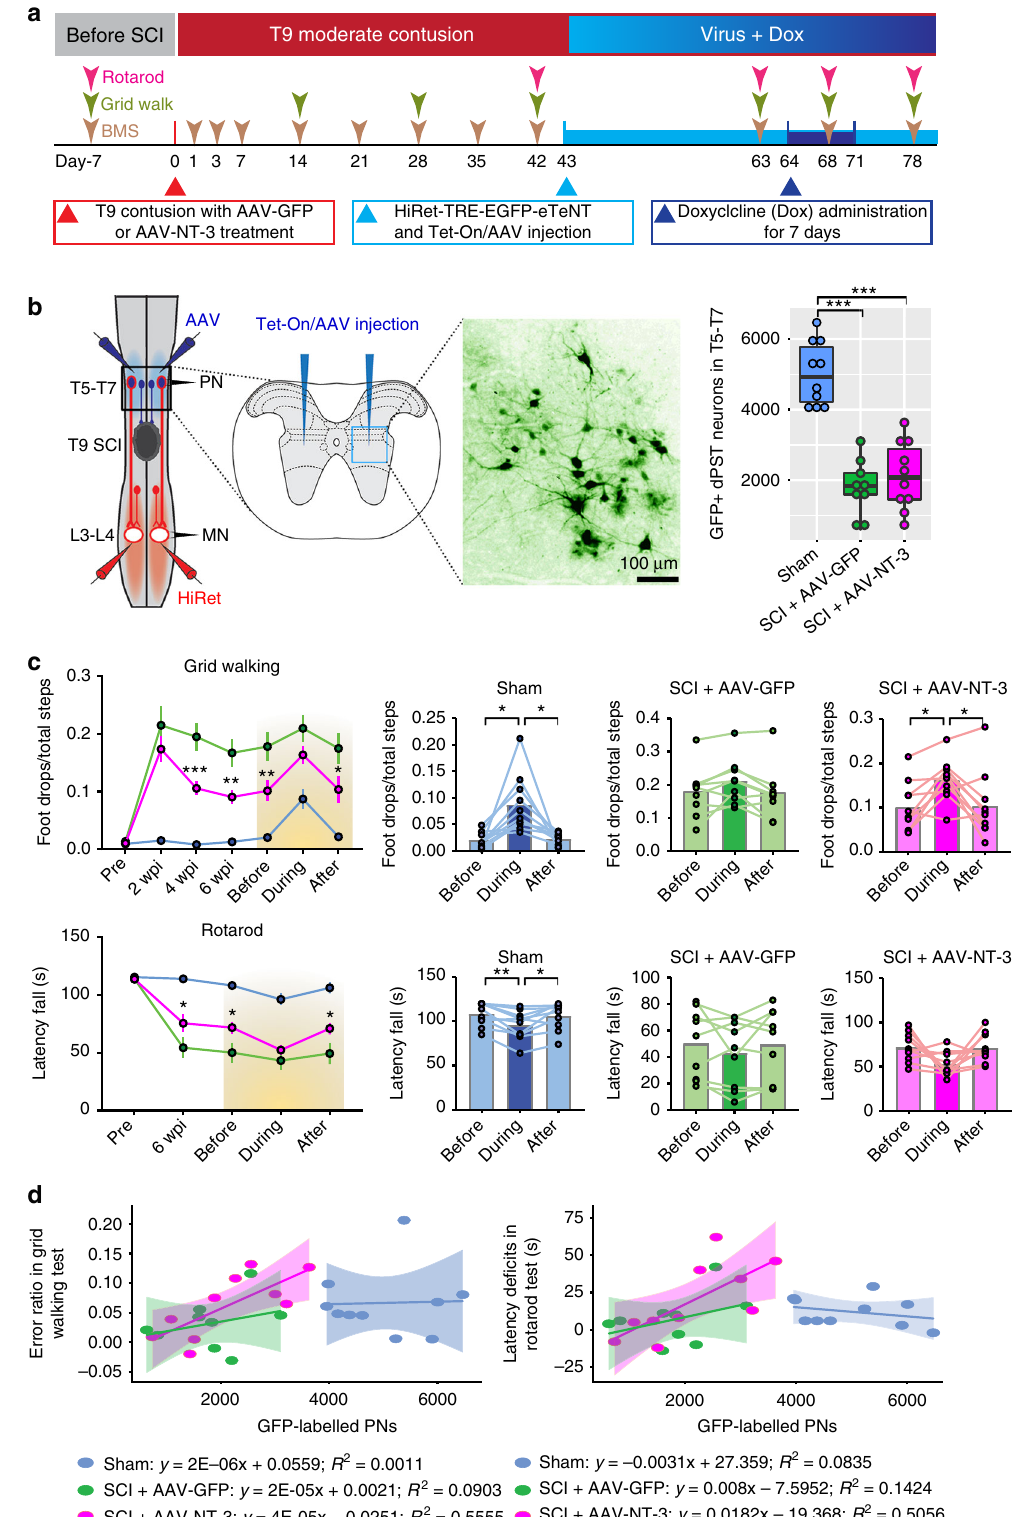
muscle in the left hindlimb showed consistent and detectable tcMMEP responses, despite abnormal latency and amplitude,